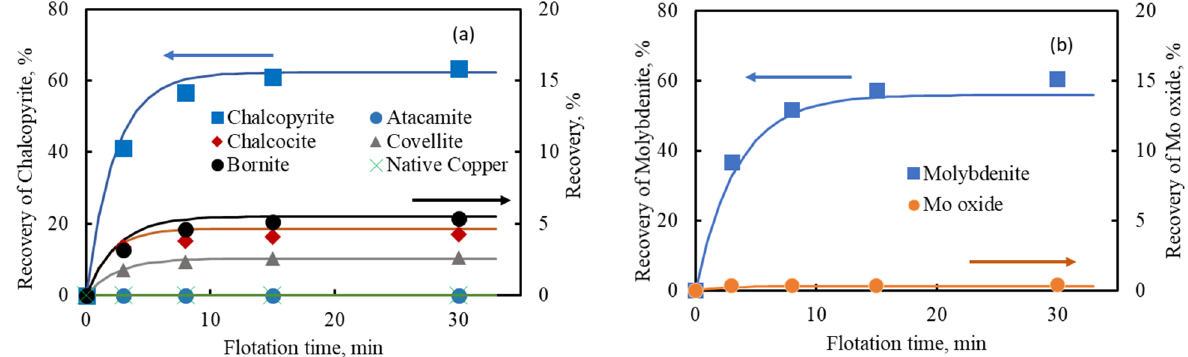
Figure 7. Comparison of actual and estimated flotation recovery of each copper mineral ( a ) and each molybdenum mineral